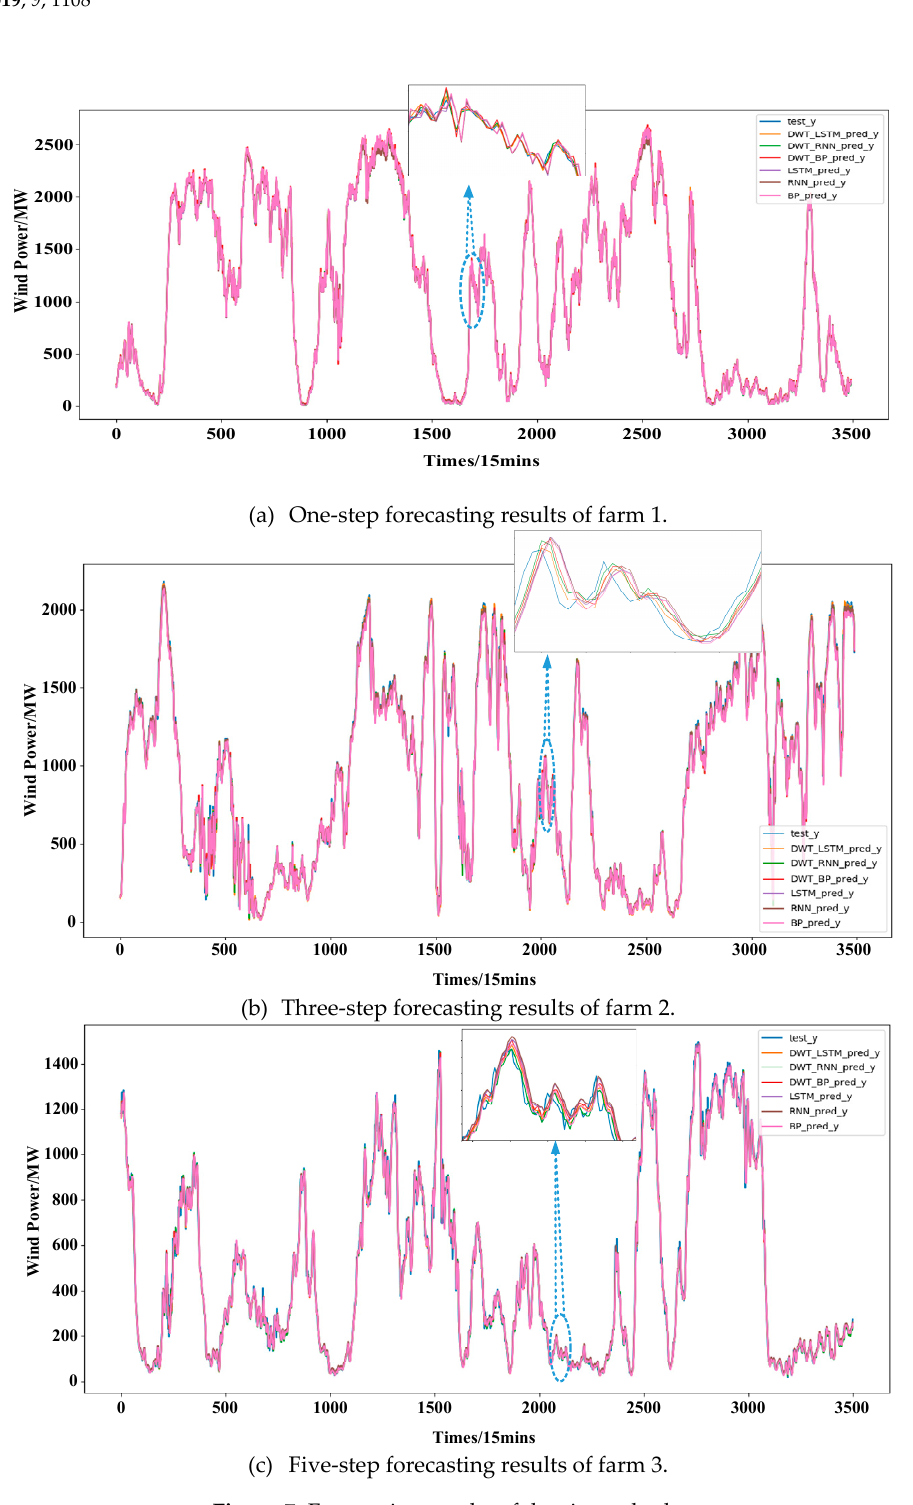
Figure 7. Forecasting results of the six methods.